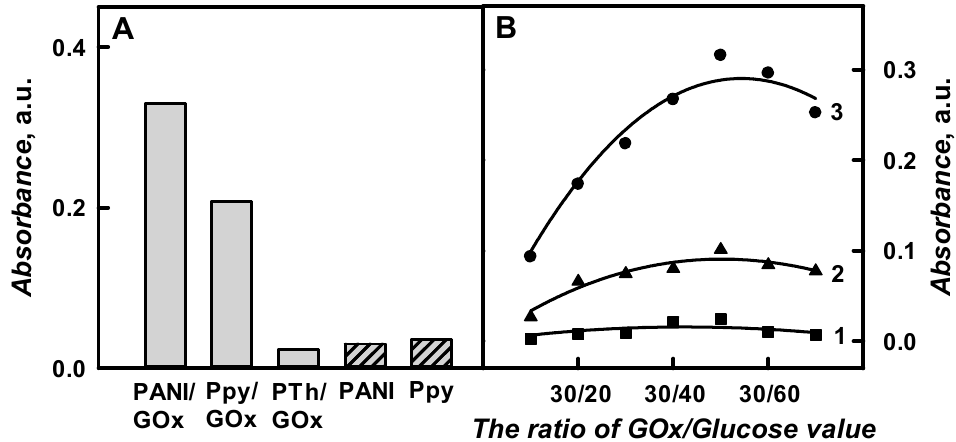
Figure 5. The diagram of optical absorbance of PANI-, Ppy-, and PTh-based composite nanoparticles in the presence and absence of GOx ( A ) and the influence of GOx/Glucose ratio on the absorbance for PTh/GOx (1 curve), Ppy/GOx (2 curve), or PANI/GOx (3 curve) composite nanoparticles colloidal solutions at pH 6.0 ( B ). (( A ) The composition of polymerization solution, pH 6.0: 0.05 mol L − 1 of glucose, 0.50 mol L − 1 of aniline, pyrrole, or thiophene and 0.75 mg mL − 1 of glucose oxidase (grey columns); the composition of solution used for autopolymerization: 0.05 mol L − 1 of glucose, 0.50 mol L − 1 of aniline or pyrrole at pH 1.0 or pH 2.0, respectively (dash columns); ( B ) The composition of polymerization solution, pH 6.0: 0.50 mol L − 1 of aniline, pyrrole or thiophene, 0.75 mg mL − 1 of glucose oxidase and 0.015–0.05 mol L − 1 of glucose. Polymerization lasted for 48 h. Optical absorbance was registered for PANI/GOx and PANI, Ppy/GOx, and Ppy, PTh/GOx at λ max = 440 nm, λ max = 460 nm, and λ max = 450 nm in 0.05 mol L − 1 SA buffer, pH 6.0).